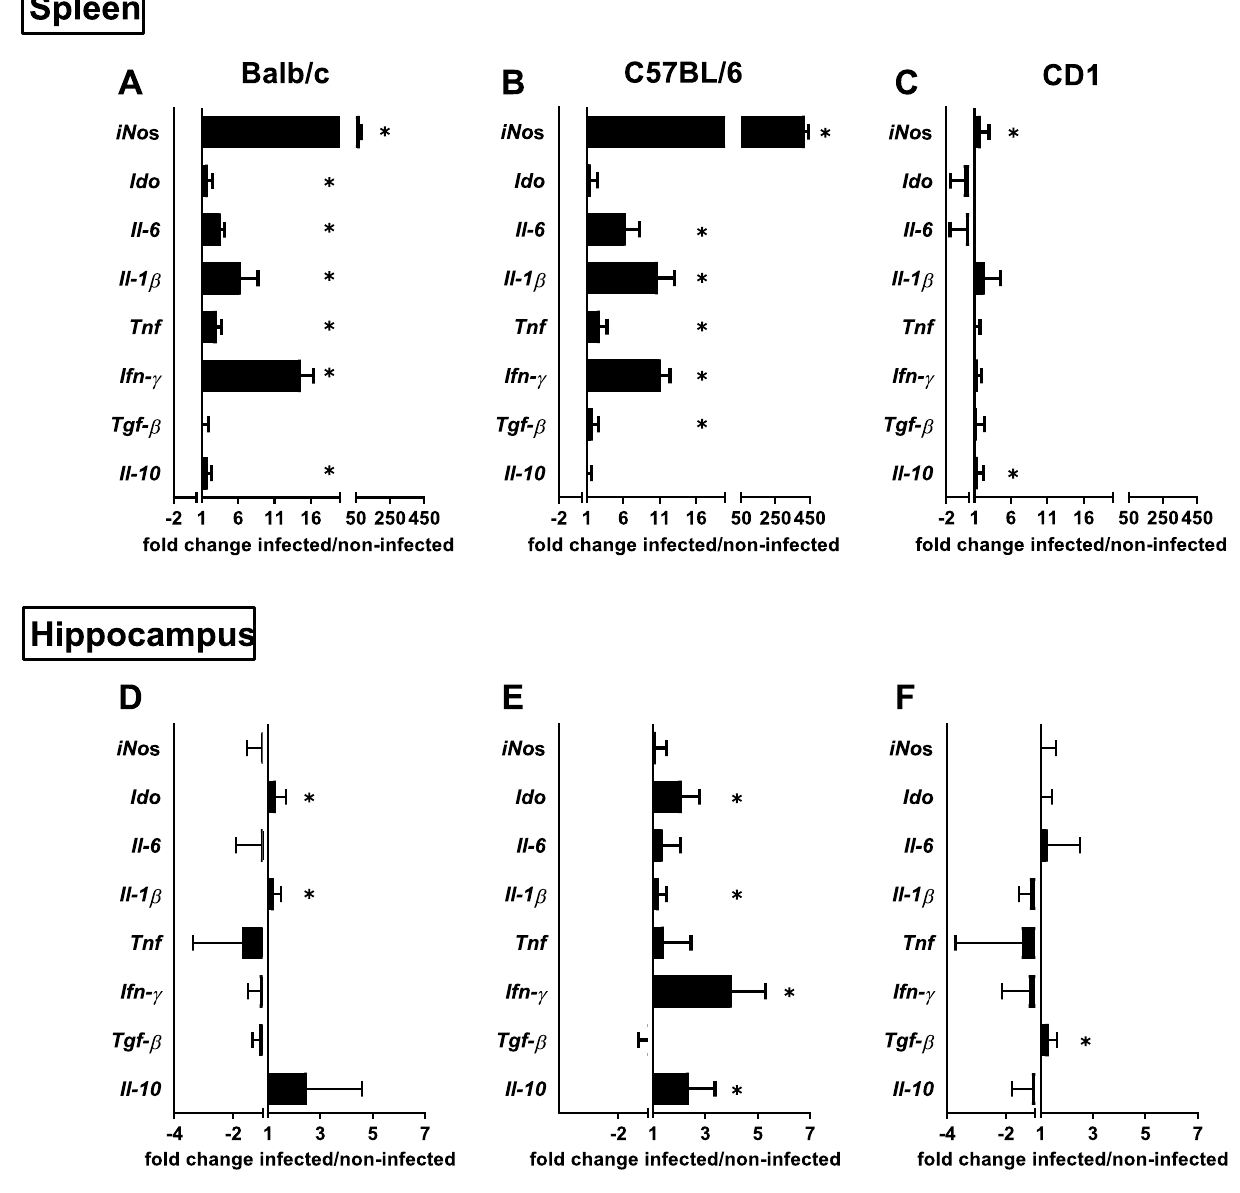
Figure 2. Chronic infection with M. avium induces a distinct cytokine/inflammatory molecules profile in the hippocampus and spleen of the different mouse strains. mRNA expression levels for the anti-inflammatory cytokines Il-10 and Tgf-β, pro-inflammatory cytokines Ifn-γ , Tnf , Il-1β and Il-6, and the inflammatory molecules Ido and iNos were measured in the spleen ( A – C ) and hippocampus ( D – F ) of Balb/c ( A and D ), C57BL/6 ( B and E ) and CD1 ( C and F ) mice at 4wpi and non-infected. The mRNA expression levels were normalized using 3 reference genes Hprt, Gapdh and 18S . Each bar represents the mean of the fold change of the ratio infected/non- infected + SEM of 6–8 mice per strain from 1 of 2 independent experiments with similar results. *p <